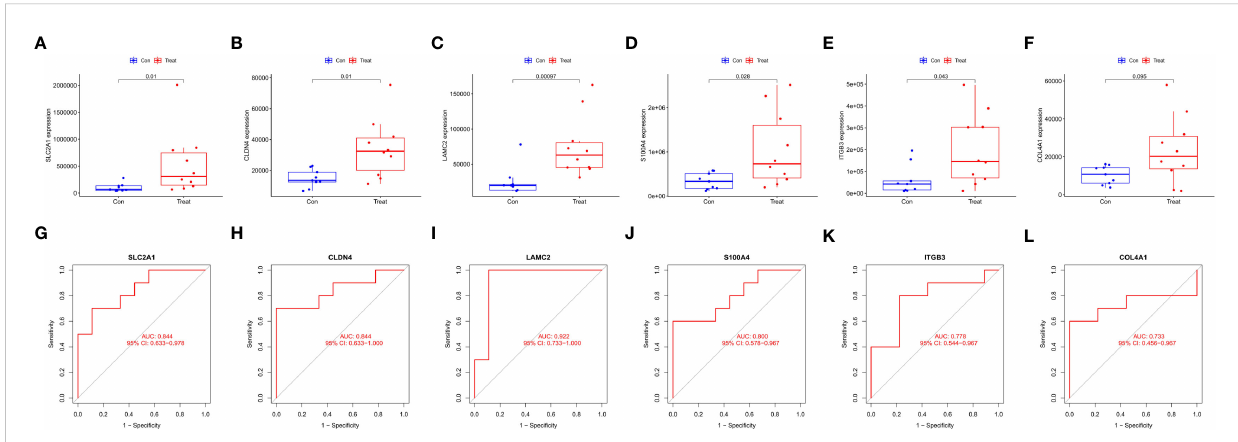
FIGURE 5 Correlation analysis between key EMT-related DEPs expression and invasiveness in proteomics: (A) SLC2A1; (B) CLDN4; (C) LAMC2; (D) S100A4; (E) ITGB3; (F) COL4A1. ROC curve of key EMT-related DEPs predicting invasiveness in proteomics: (G) SLC2A1; (H) CLDN4; (I) LAMC2; (J) S100A4; (K) ITGB3; (L)